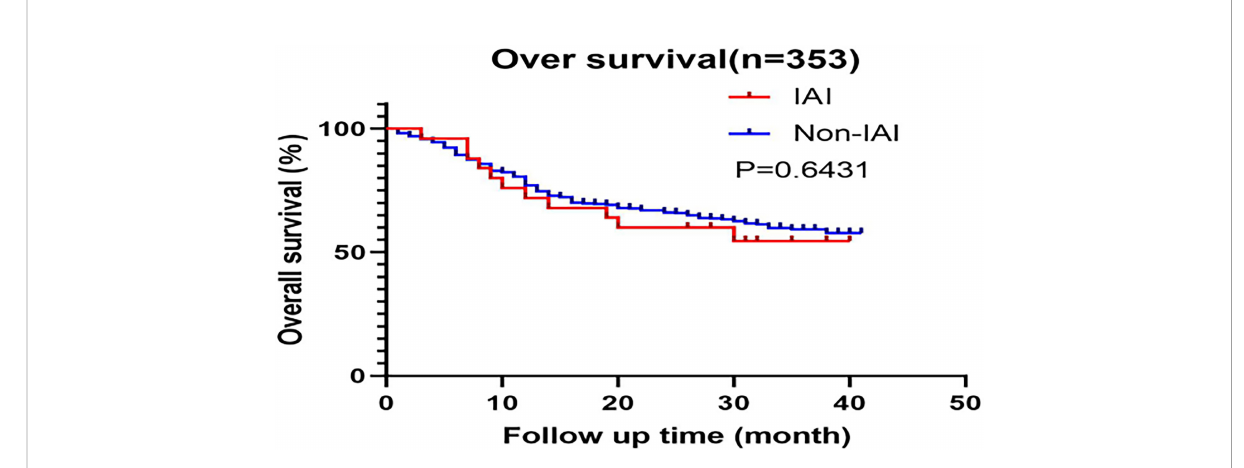
FIGURE 2 Kaplan-Meier curves of overall survival based on the training data.